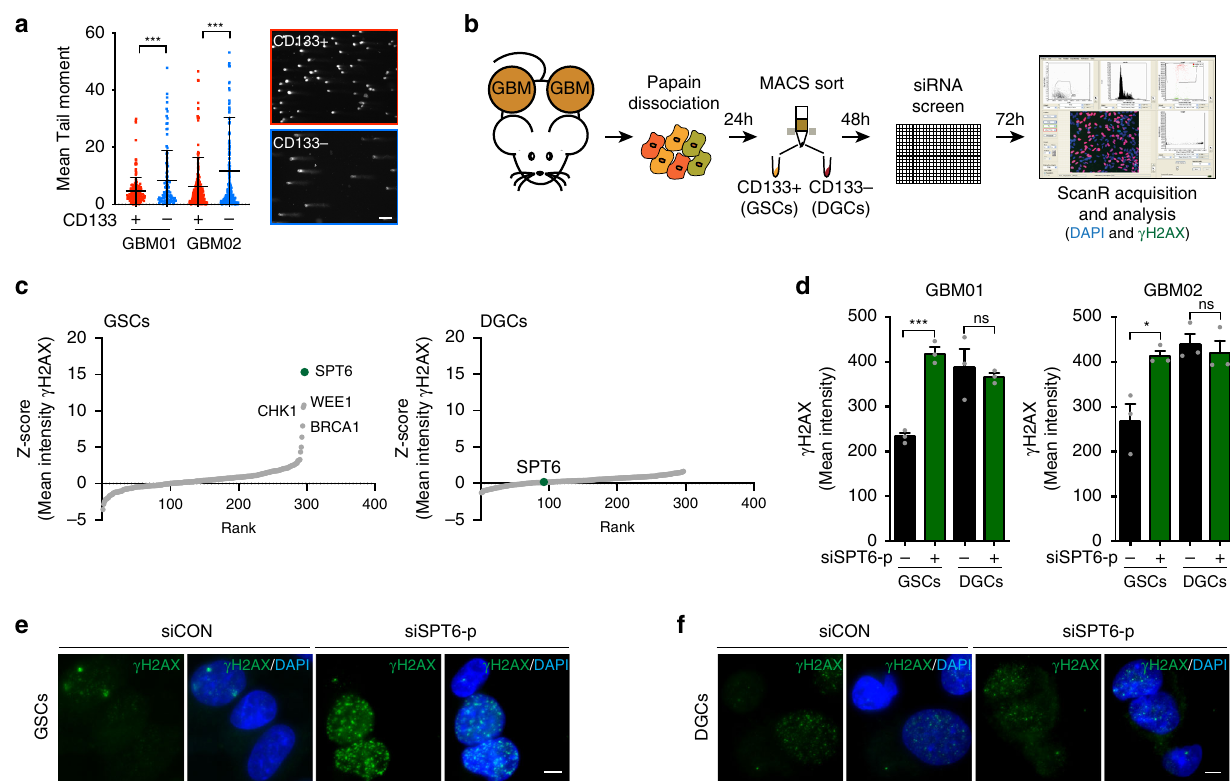
Fig. 1 High-throughput siRNA screen identi fi es SPT6 as a regulator of genomic stability in glioblastoma stem-like cells. a DSBs quanti fi cation using a comet assay in matched GSCs and DGCs isolated from GBM01 and GBM02 GBM lines. Data are presented as mean values ± s.d. **** p < 0.0001 (GBM01), *** p = 0.0003 (GBM02); two-tailed unpaired t -test. The right part of the panel is showing representative images of comets captured using 10x objective. Scale bar = 100 μ m. b Schematic illustration of siRNA microscopy-based screen work fl ow. c A scatter plot of z- scores derived from the siRNA screen for inducers of DSBs in matched GSCs and DGCs. The position of the three high-scoring hits with a reported role in DNA repair (WEE1 and CHK1) and our positive control (BRCA1) are indicated. The top-scoring hit, SPT6, is highlighted as a green dot. d γ H2AX mean intensity quanti fi cation in matched GSCs and DGCs (GBM01 and GBM02) transfected with siCON or a pool of three independent siRNAs (siSPT6-p). Data are presented as mean values ± s.e.m. *** p = 0.0004 (GBM01-GSCs), non-signi fi cant ns = 0.637 (GM01-DGCs), * p = 0.022 (GBM02-GSCs), non-signi fi cant ns = 0.631 (GBM02-DGCs); two- tailed unpaired t -test. e , f Representative confocal microscopy images of γ H2AX staining (green foci) in SPT6 silenced (siSPT6-p) GSCs ( e ) and DGCs ( f